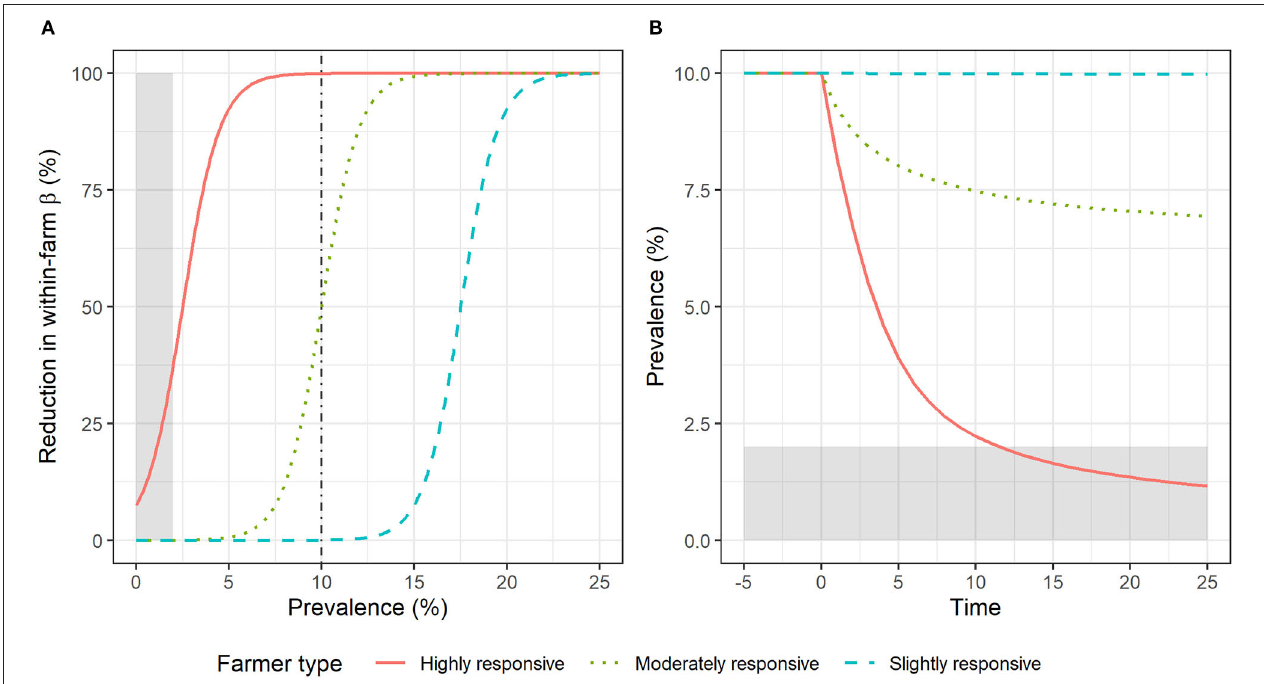
FIGURE 1 | Effect of farmer type on disease prevalence following a common starting prevalence and a hypothetical awareness-raising event (at time zero). (A) Control effort applied (percentage reduction in transmission rate— β —within the farm in relation to the initial β in endemic equilibrium) as a function of disease prevalence for three different farmer types. The vertical dash-dotted line indicates initial prevalence. (B) Disease prevalence over time within the three farms. In both panels, the gray shaded area indicates the target prevalence level from society’s perspective ( <